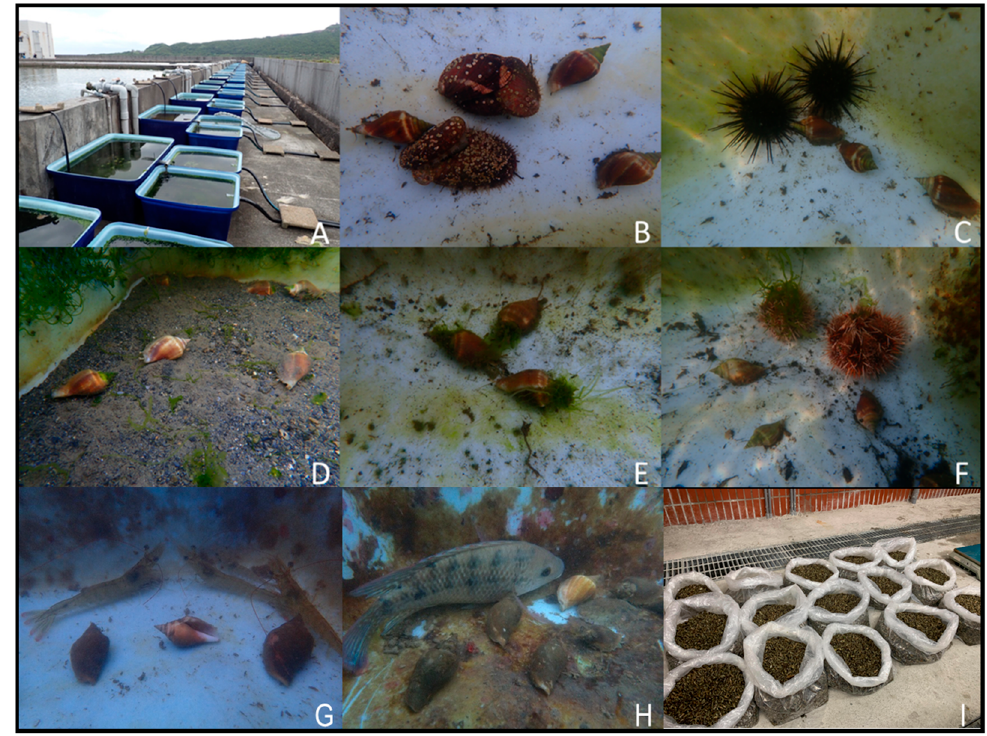
Figure 2. The experiment of juvenile Laevistrombus canarium cocultured outdoor with different spe- cies. ( A ) plastic tank: 60 × 45 × 90 cm; ( B ) abalone Haliotis diversicolor ; ( C ) purple sea urchin Antho- cidaris crassispina ; ( D ) with sands; ( E ) control; ( F ) collector urchin Tripneustes gratilla ; ( G ) shrimp Litopenaeus vannamei ; ( H ) tilapia Oreochromis mossambicus ; ( I ) mass production of juveniles in the Gongliao Aqua